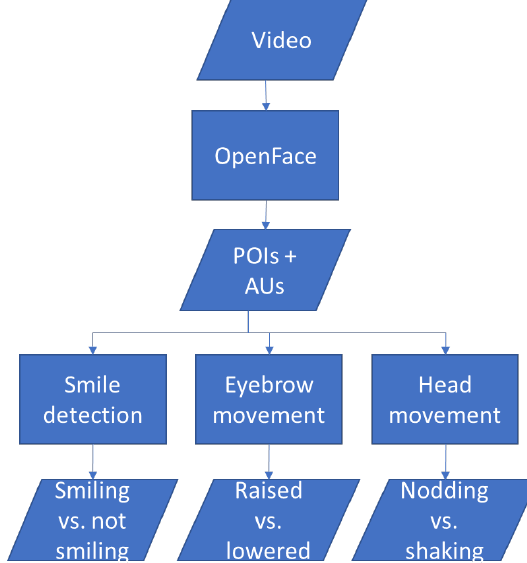
Figure 3 | Facial Expression Detection